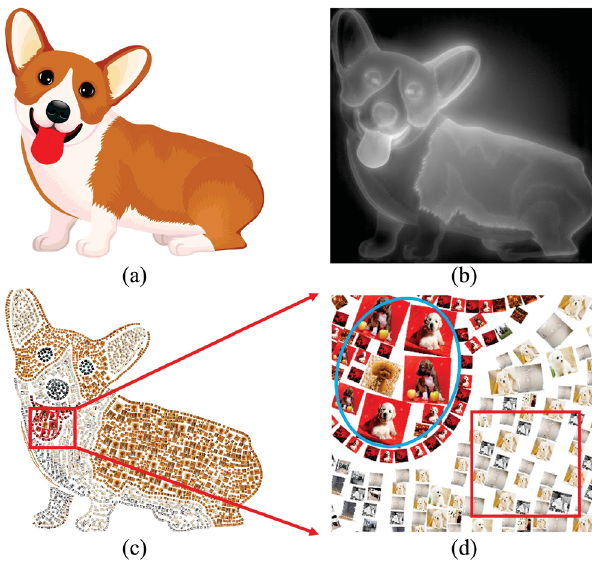
Fig. 6 Collage with theme “dog”: (a) source image; (b) saliency map; (c) generated collage; (d) detail within red rectangle.